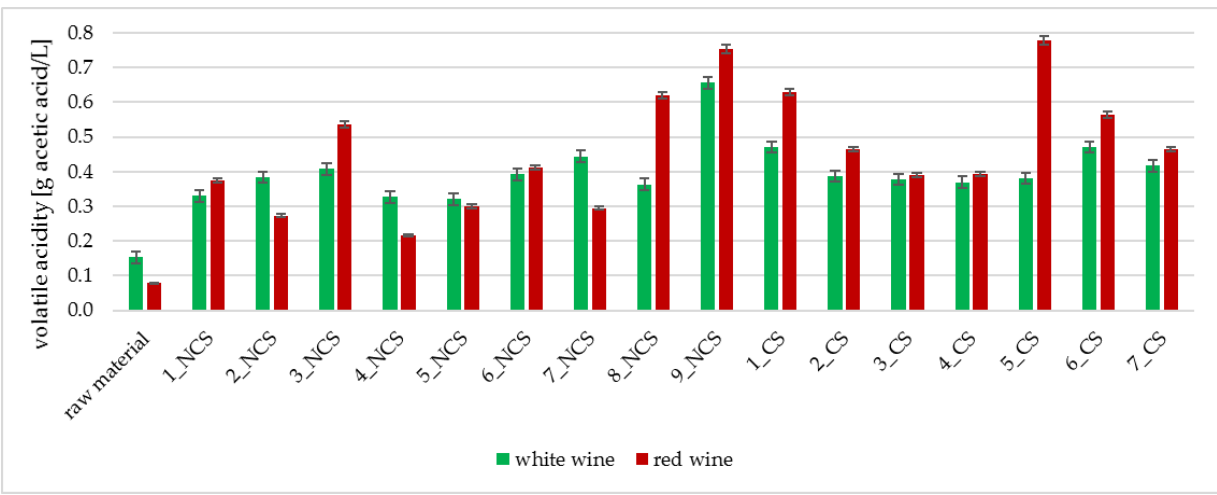
Figure 5. Volatile acidity of white and red wines.